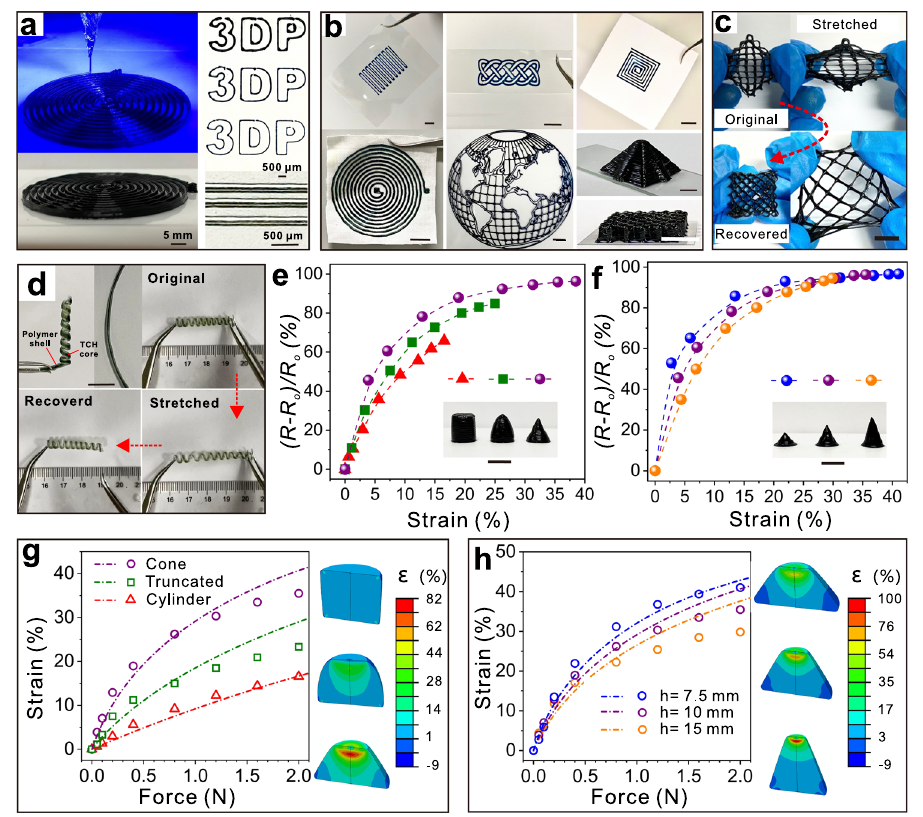
Fig. 4 Fabricating 3D TCHs with the extruding printing technique. a Digital images of printed spiral TCHs via a typical extrusion 3D-printing technique (nozzle size: 22 G, moving rate: 5 mm s − 1 ). b Digital images of different TCH patterns and 3D structures on polyethylene terephthalate, indium-tin-oxide- coated glass, paper, and cotton fabric substrates. c Omnidirectionally stretching a TCH mesh. The mesh was fi rst made by extrusion 3D-printing